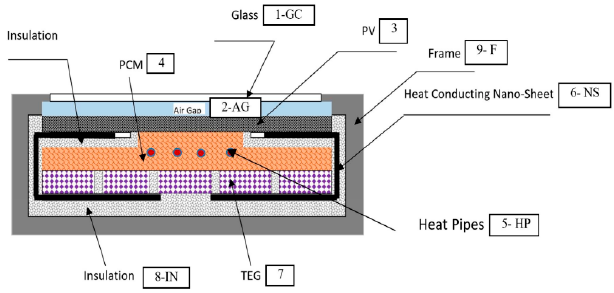
Figure 8. Photo-Heat-Voltaic-Thermal (PVT-3) Module (not to scale) [61,62].